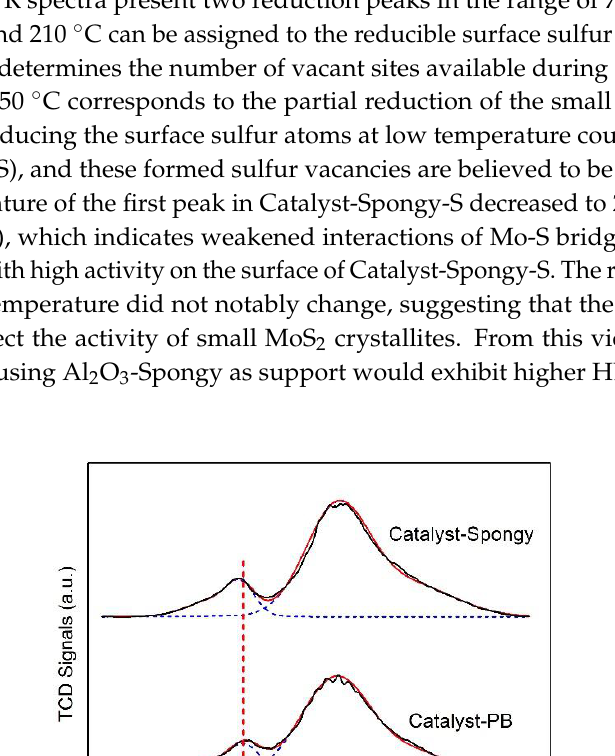
Figure 5. XRD patterns of the oxidation state and sulfurized CoMo/Al 2 O 3 catalysts using Al 2 O 3 -Spongy and Al 2 O 3 -PB as support.